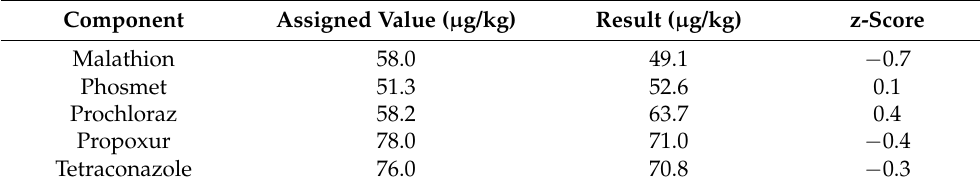
Table 6. Milk powder, proficiency test 5161 (FAPAS), September